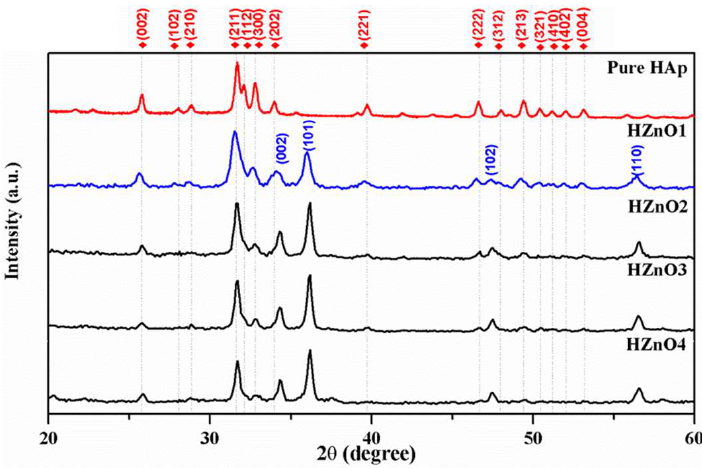
Figure 1. XRD patterns of pure HAp and HAp-ZnO composites.